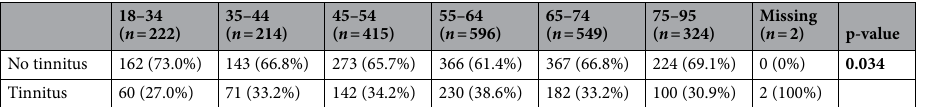
Table 4. Number (%) of subjects reporting tinnitus by age group. p-value is from a chi-squared test excluding the missing category. Bold indicates statistically significant p <